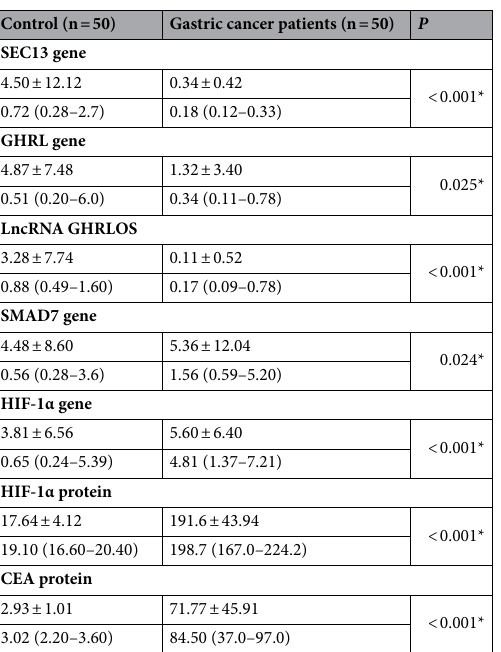
Table 2. SEC13, GHRL, lncRNA GHRLOS, SMAD7, HIF-1α genes expression, serum HIF-1α (ng/ml) and CEA level (ng/ml) in control and gastric cancer patients’ groups. Mean ± S.D. and Median (IQR). n: number of cases. P: P value for comparing between GC patients and control group utilizing Mann Whitney test. *Significance at P ≤